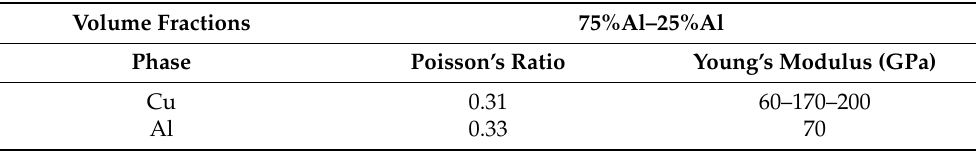
Table 1. Elastic simulation parameters for investigating the development of transverse stresses in CCA wires.